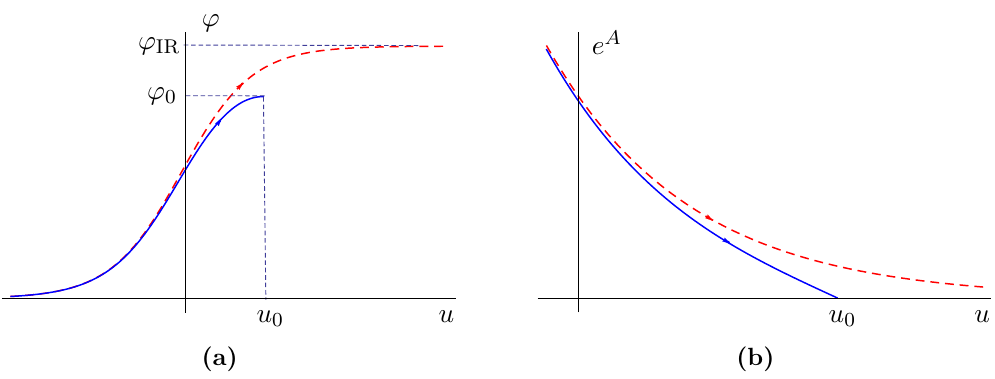
Figure 2. The solid lines show the scalar (cid:12)eld (left) and scale factor (right) pro(cid:12)les of a positive curvature RG (cid:13)ow geometry, from the UV ( u ! (cid:0)1 , ’ ! 0) to the IR endpoint ( u = u 0 , ’ = ’ 0 ). The dashed lines represent the solutions with zero curvature, extending all the way to u ! + 1 and to the IR (cid:12)xed point at ’ = ’ IR